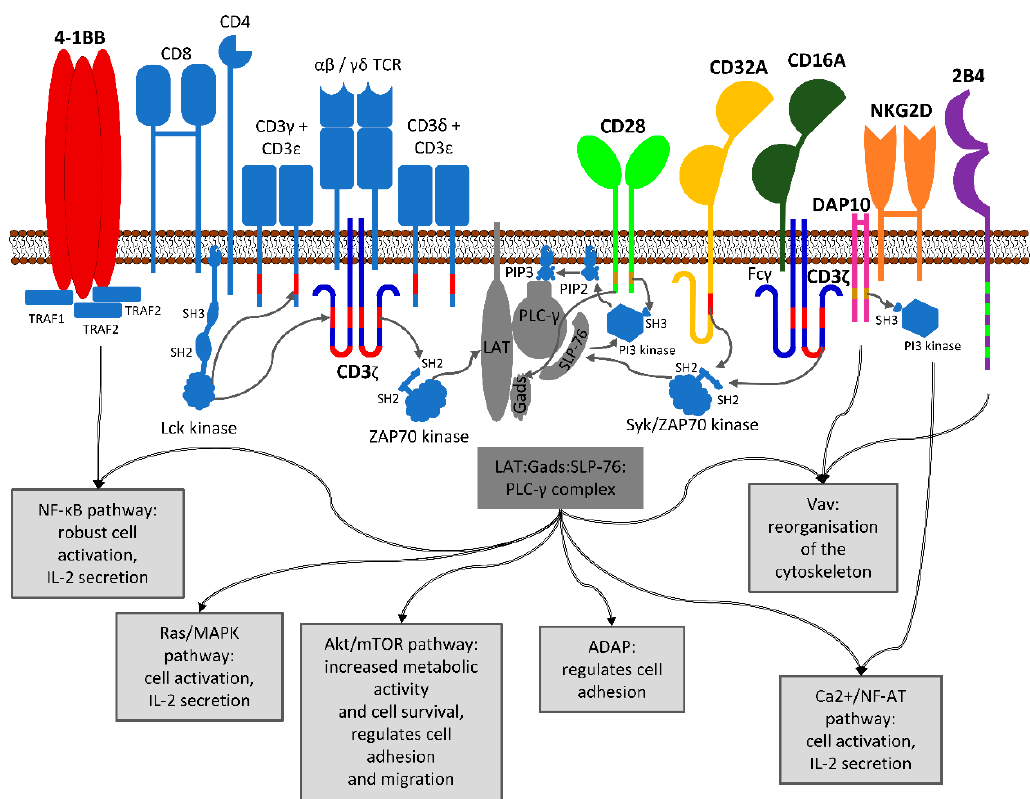
Figure 2. Summarizing representation of the normal roles of potential CAR signaling domains. Arrows indicate how the signaling pathways of different surface receptors are interconnected respectively to find resemblance in other cell types. Golden bars represent SH3 binding motifs, light green bars ITSMs, red bars ITAMs. More details on the individual proteins are discussed in the text.